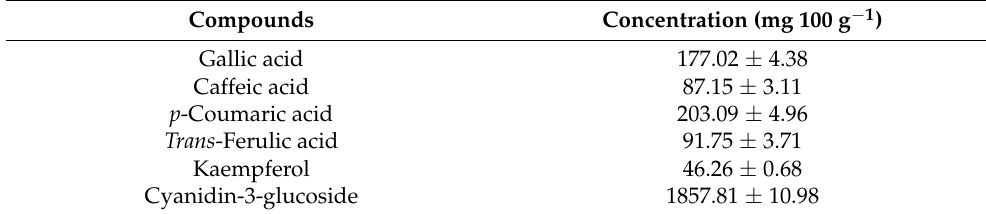
Table 1. Identified phenolic compounds in